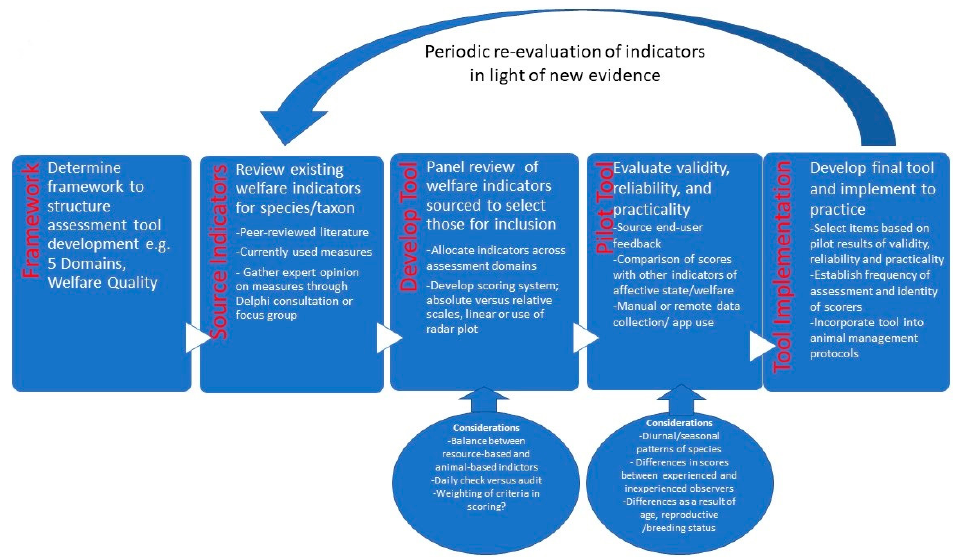
Figure 2. Summary flowchart of steps and considerations involved in deriving a welfare assessment tool for use in zoos.